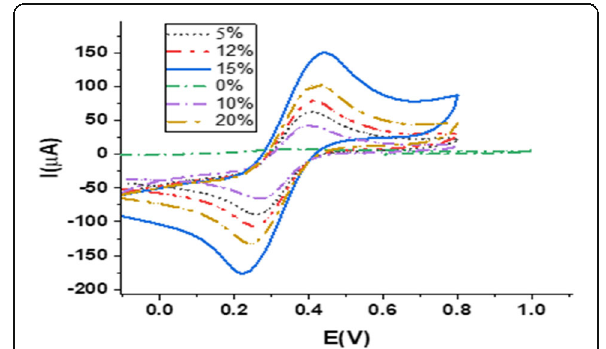
Fig. 3 Background-subtracted cyclic voltammograms at 50 mVs − 1 at bare CPE, and ratios of Fe 2 O 3 NP/CPEs in 1 mM K 4 Fe(CN) 6 /0.1 M KCl solution